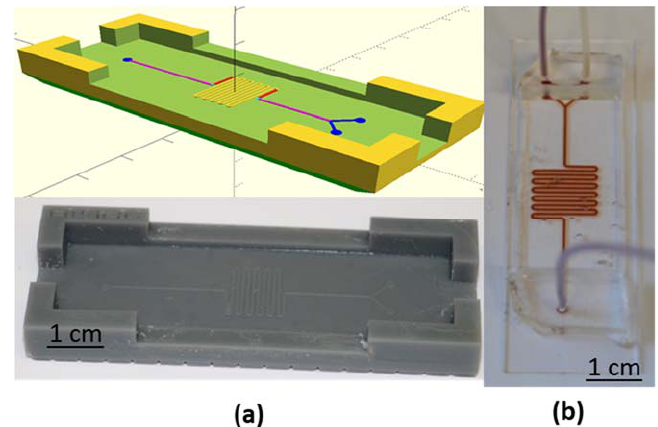
Figure 4. ( a ) Three ‐ dimensional (3D) printed master mold and ( b ) microfluidic channel, filled with a